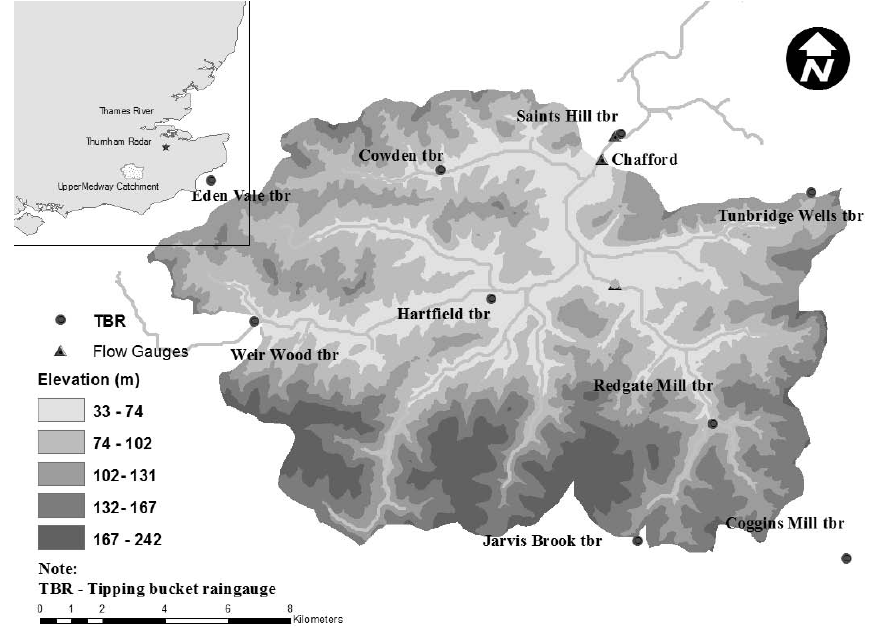
Fig. 1. The upper Medway catchment with raingauges location and